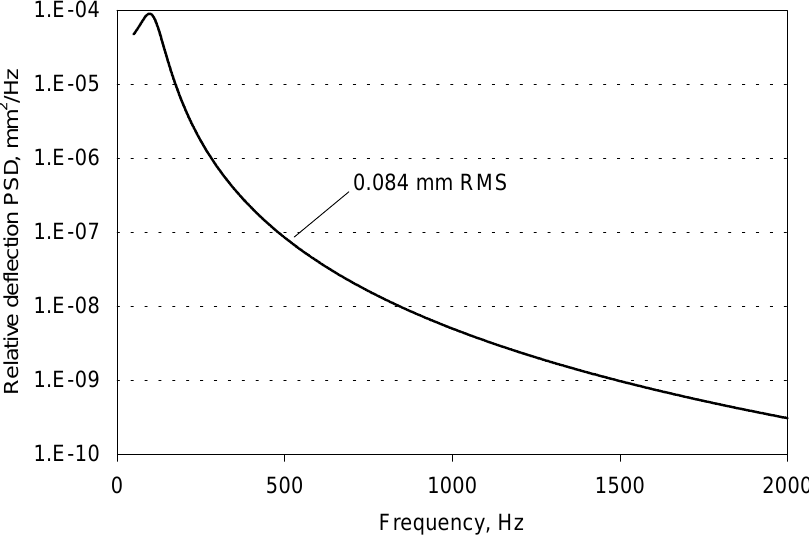
Fig. 11. Dynamic deflection of optimised vibration